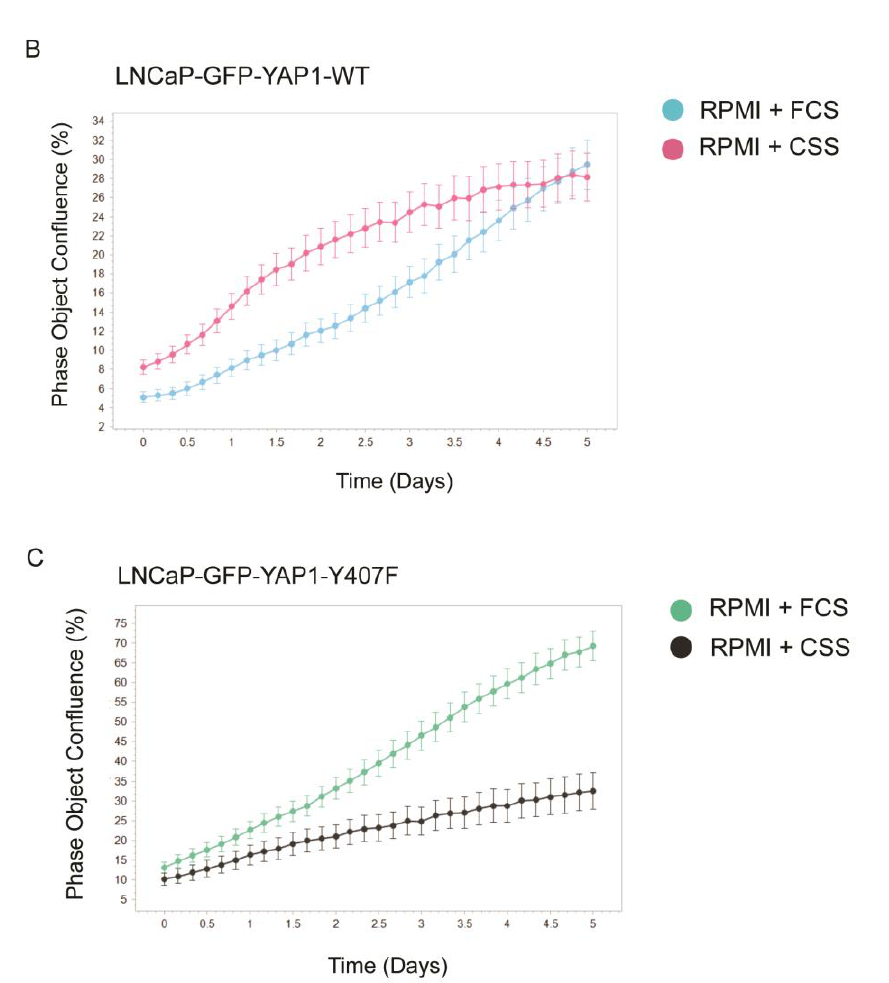
Figure 3. Only LNCaP cells expressing GFP-YAP1-WT were androgen-independent for growth. ( A ) LNCaP-GFP control cells exhibited slower growth in androgen-deprived media (charcoal stripped serum—CSS) compared to normal complete growth media (with Fetal calf serum, FCS). ( B , C ) LNCaP cells expressing GFP-YAP1-WT, but not the Y407F mutant were intrinsically androgen-independent (AI) for growth shown for indicated time. LNCaP cells expressing GFP-YAP1-WT, GFP-YAP1-Y40F, or vector control GFP, were plated in 96 well plates at 10,000 cells per well and monitored for growth over a week period with the Incucyte.